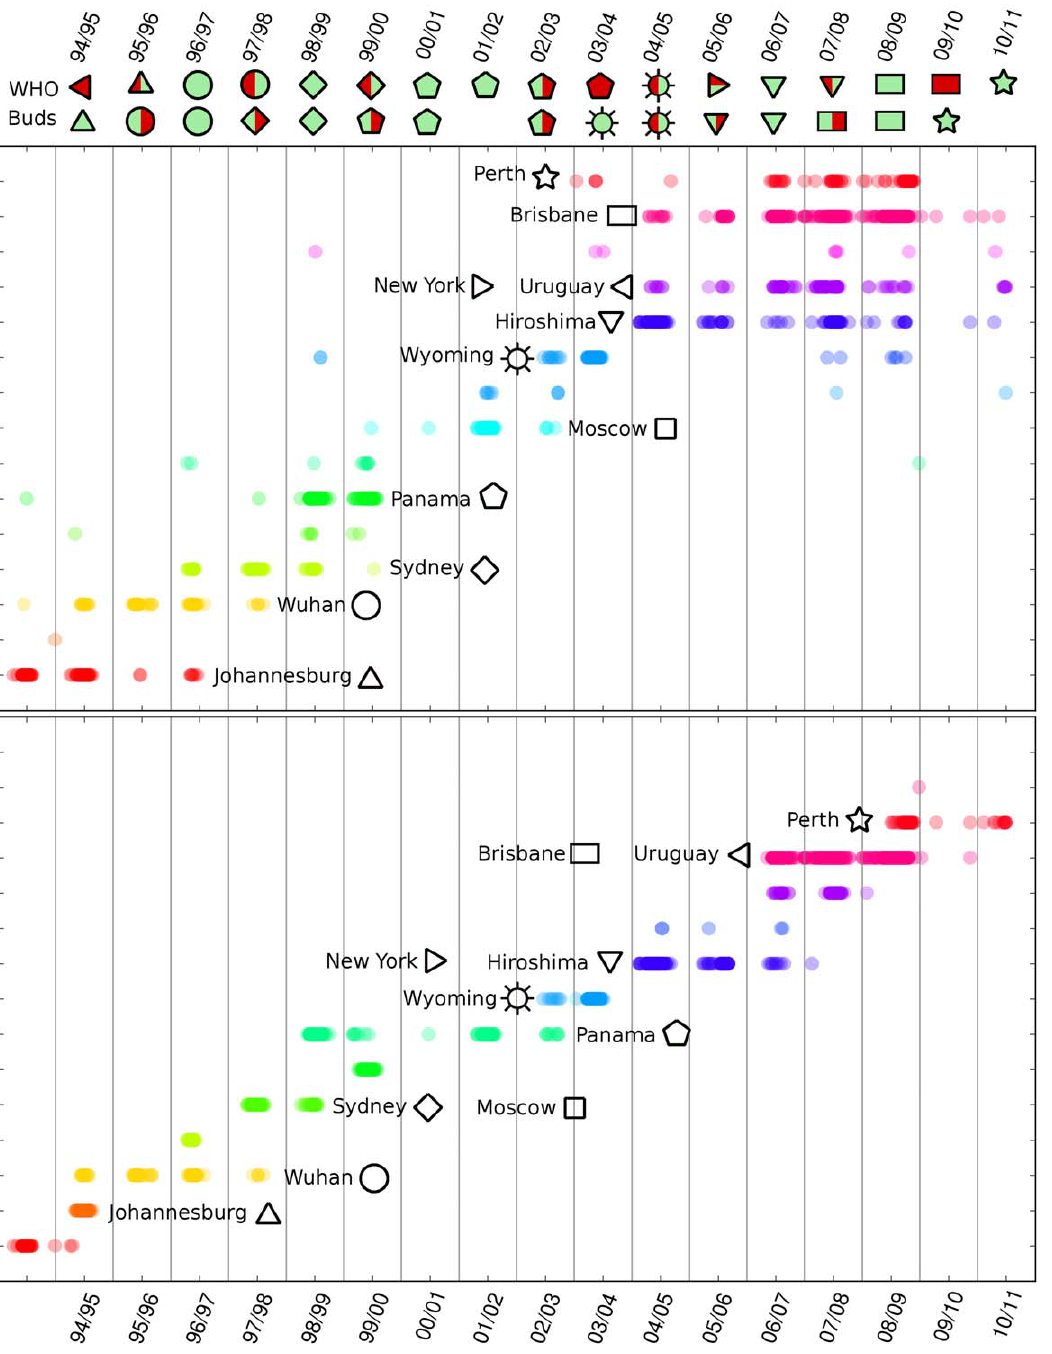
Figure 2. Clusters and time evolution for H3N2. (upper part) Rohlin clusters time evolution for H3N2. (lower part) Hamming clusters time evolution for H3N2. The reference WHO sequences are shown by the corresponding symbols and names, and the details are indicated in Table 1. In the upper part, we indicate the vaccine choice according to the WHO indication (up) and to buds criterion (lower). Green and red colors indicate right and wrong choice with respect to the corresponding analysis on the real circulating strain. A double color is used when more than one strain circulated in that year and the corresponding prediction agrees with one of the circulating strain.